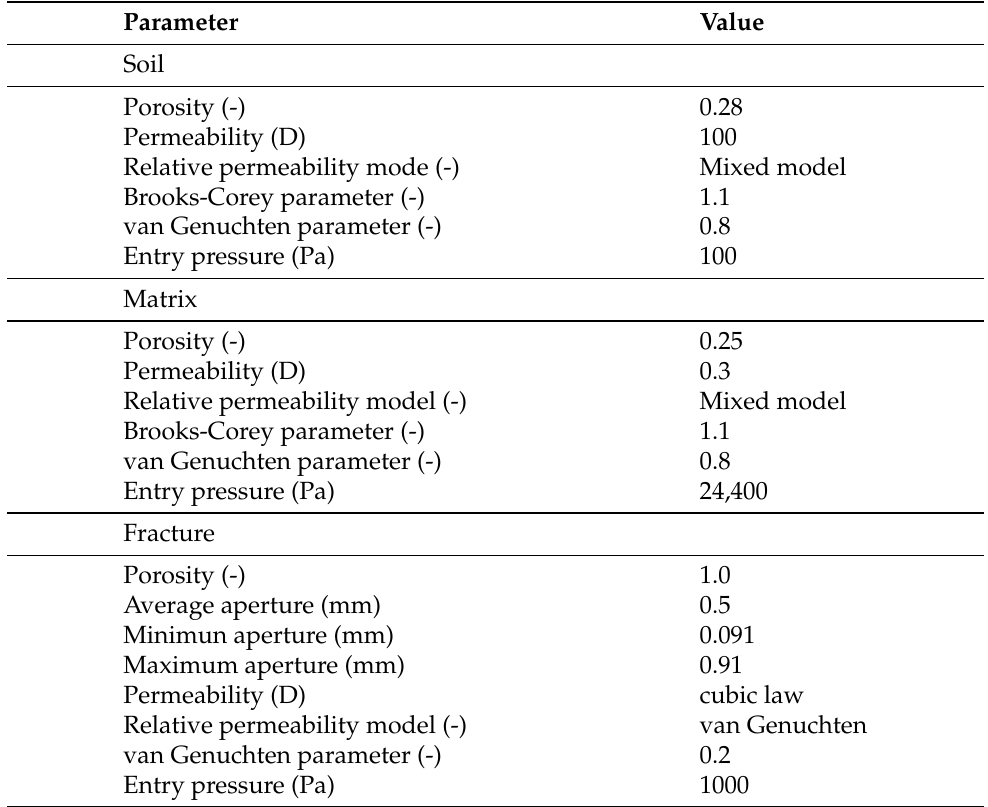
Table 3. Parameterisation of 3D fractured tuff models TUFF3D and